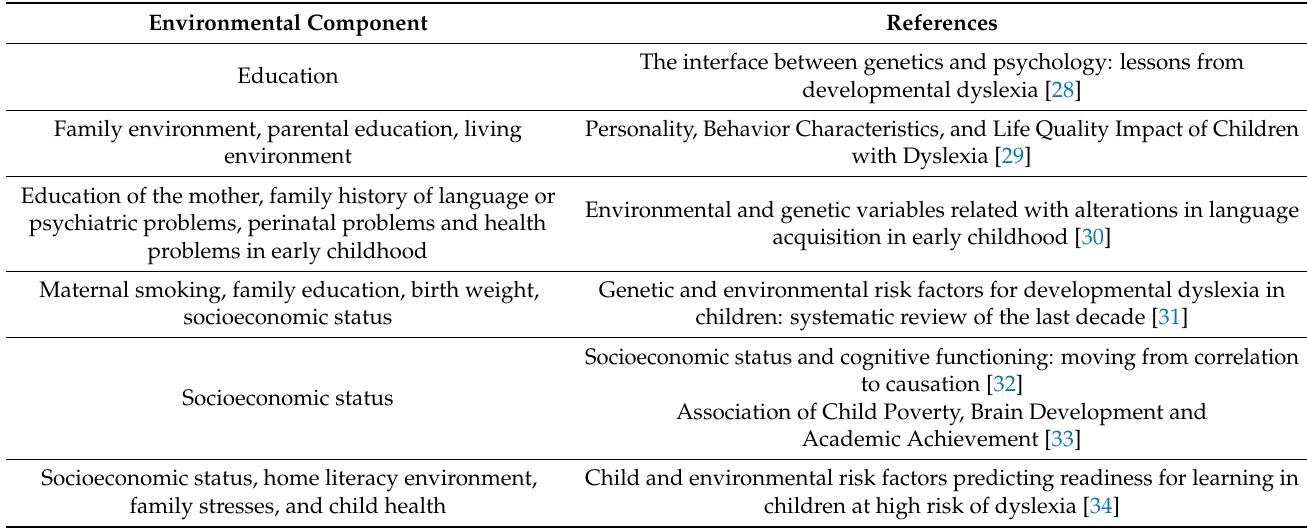
Table 1. Environmental components that may influence developmental dyslexia and sources of evidence. Environmental